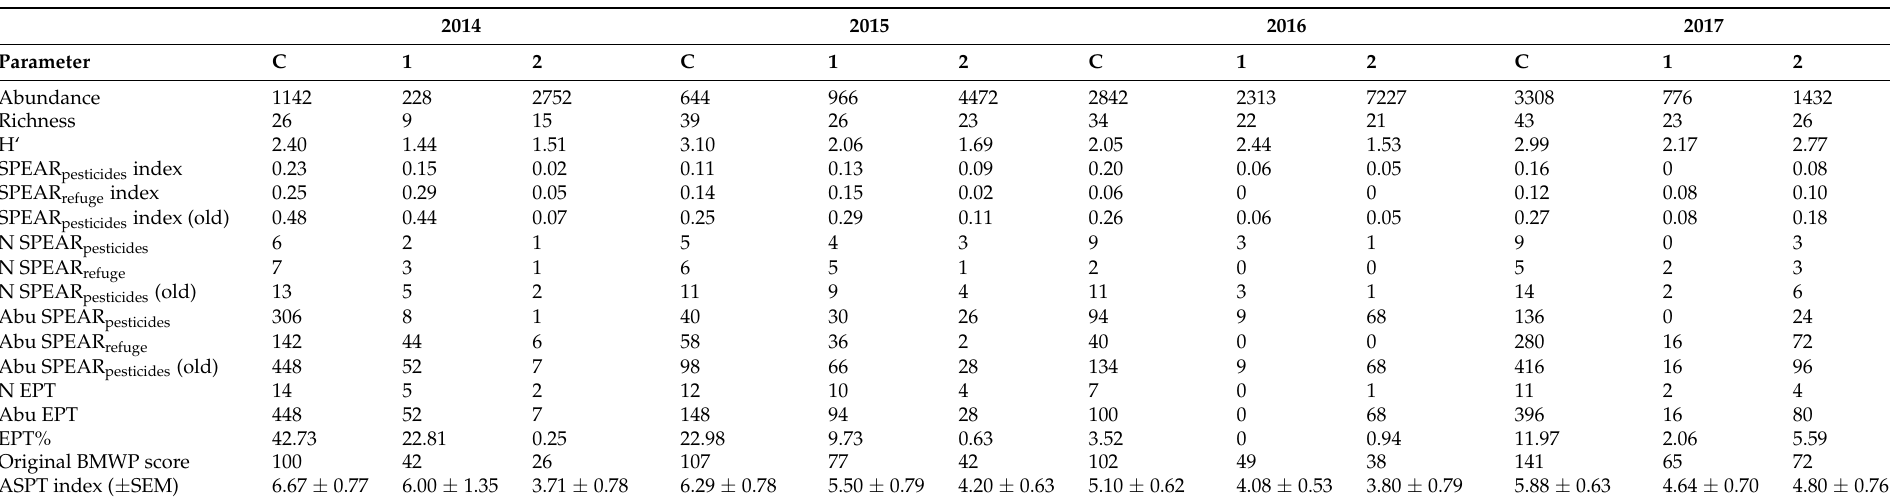
Table 3. Summary of macroinvertebrate community parameters calculated for each sample within the sampling period (2014–2017). Abbreviations: Shannon–Wiener index (H’), number of species (N), Abundance (Abu). For meaning of parameters, see Section